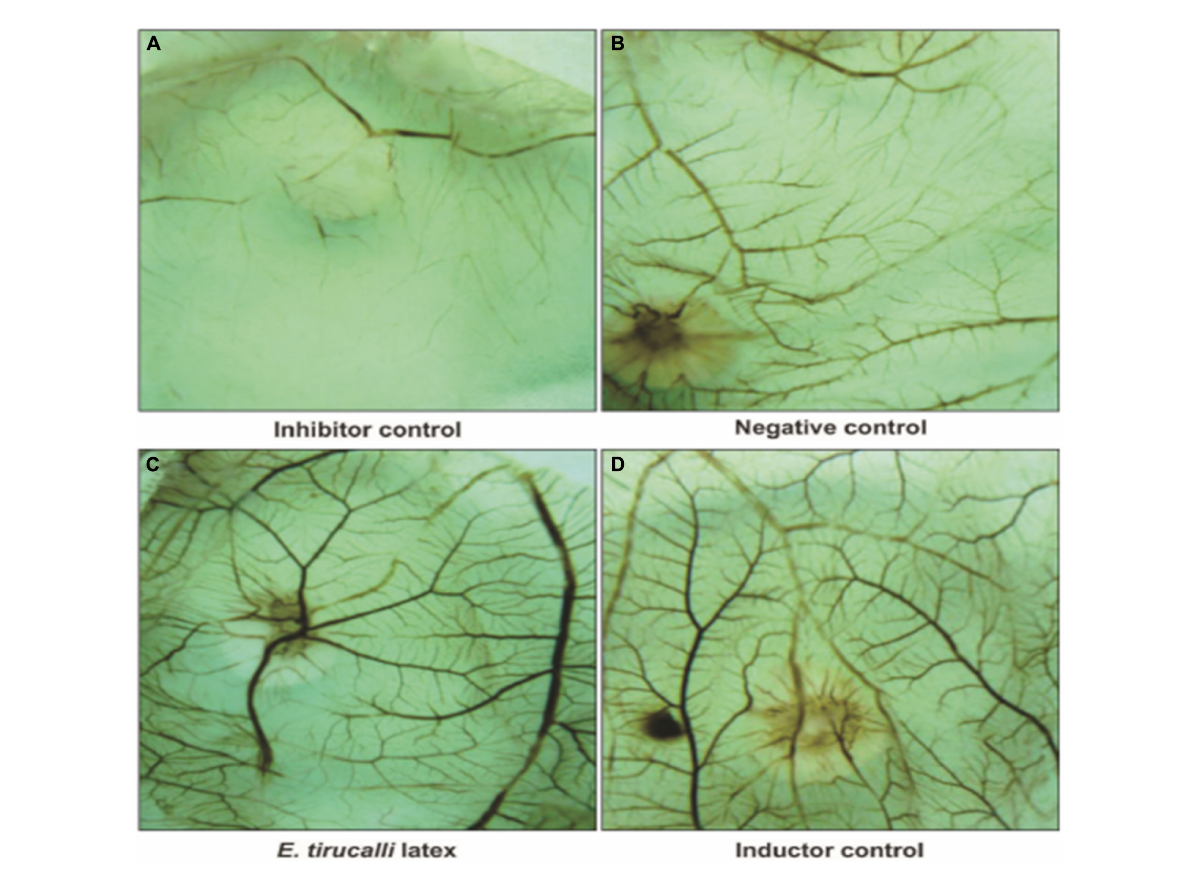
FIGURE17 Photomicrography of Chorioallantoic membrane (CAM) vascular network formation. (A) Inhibitor dexamethasone; (B) the negative control (water); (C) the test solution ( E. tirucalli ); and (D) the inducer control (Biocure Biomembrane) (Bessa et al., 2015).